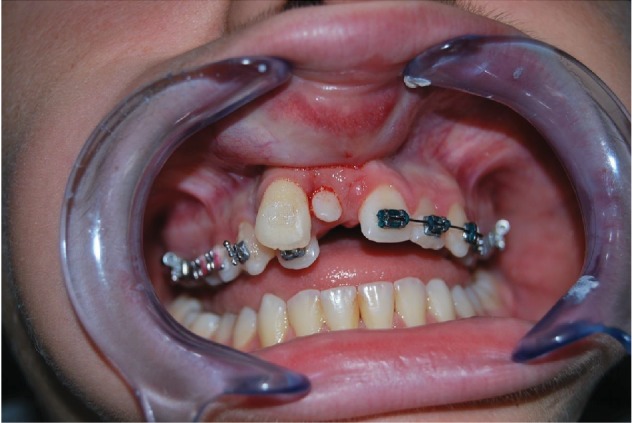
Local anaesthetic.